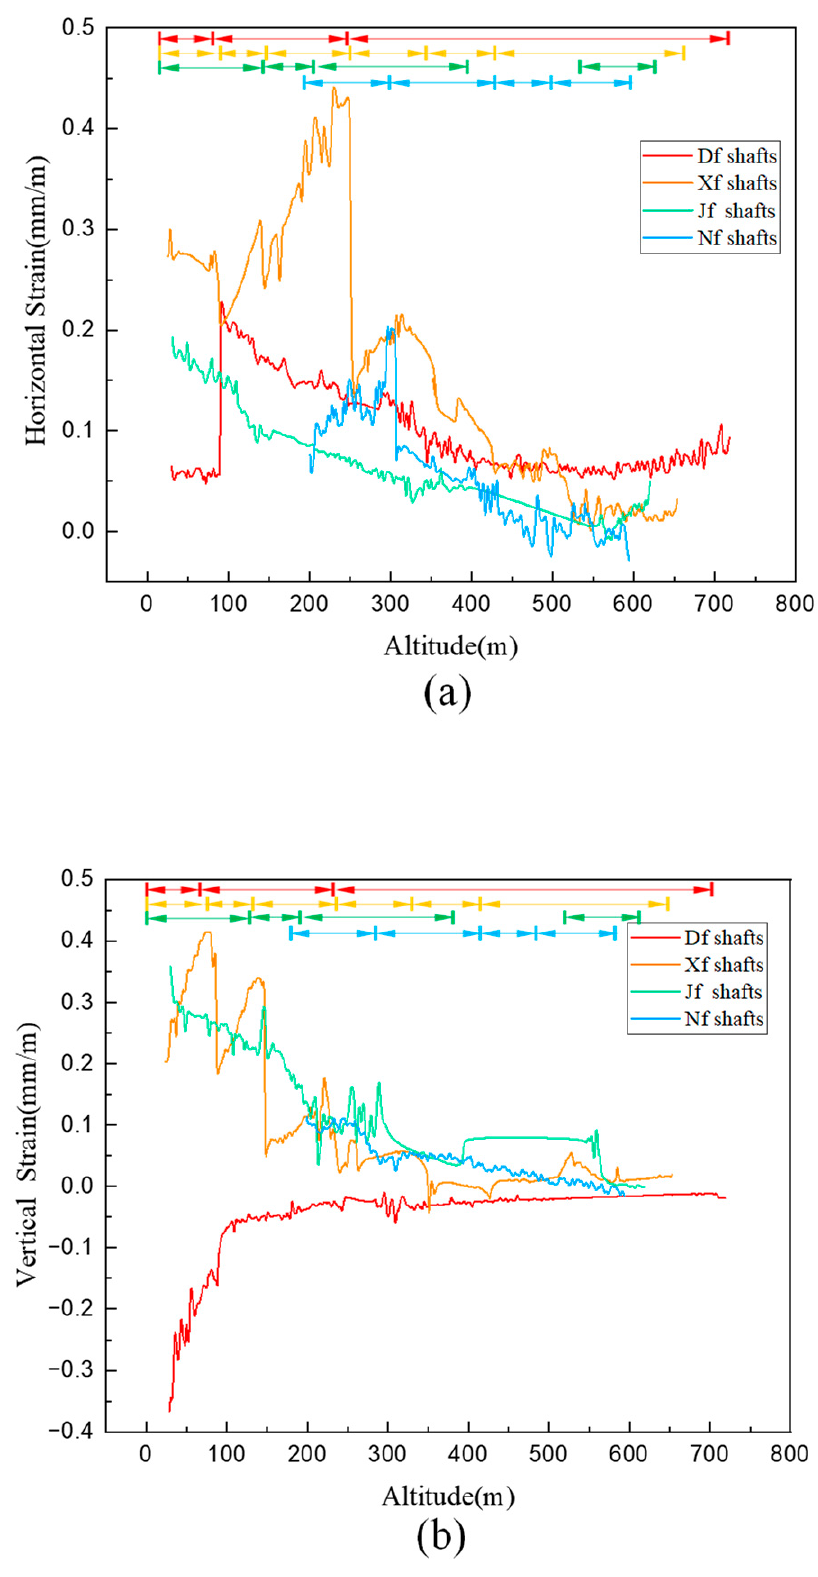
Figure 15. Final horizontal and vertical strains of four group of shafts (The altitude lower, the depth rises, and the shafts are numbered from the surface) ( a ) Horizontal strain of the shafts; ( b ) Vertical strain of the shafts.